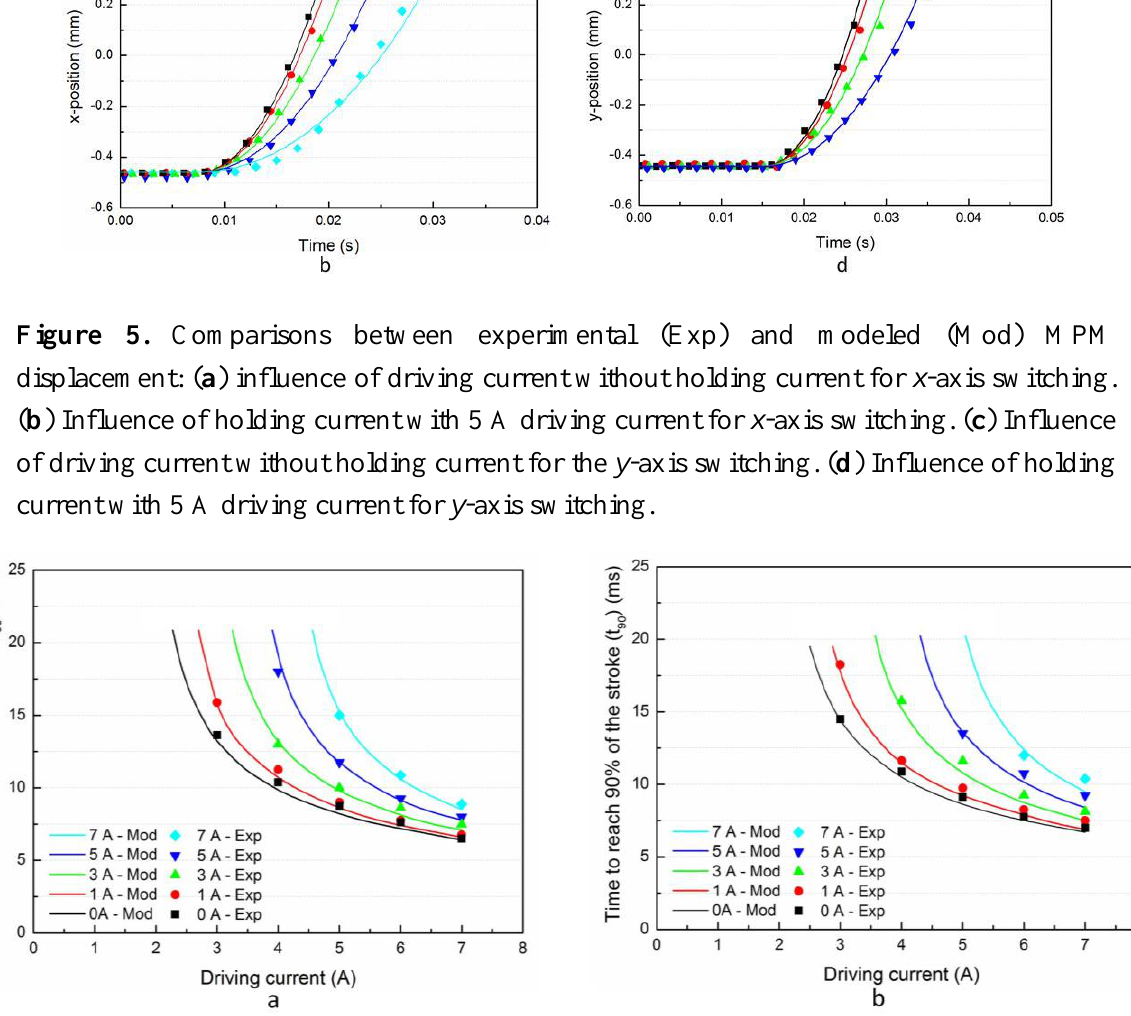
Figure 6. Comparisons between experimental (Exp) and modeled (Mod) rise times: ( a ) rise times for x -axis switching, and ( b ) rise times for y -axis